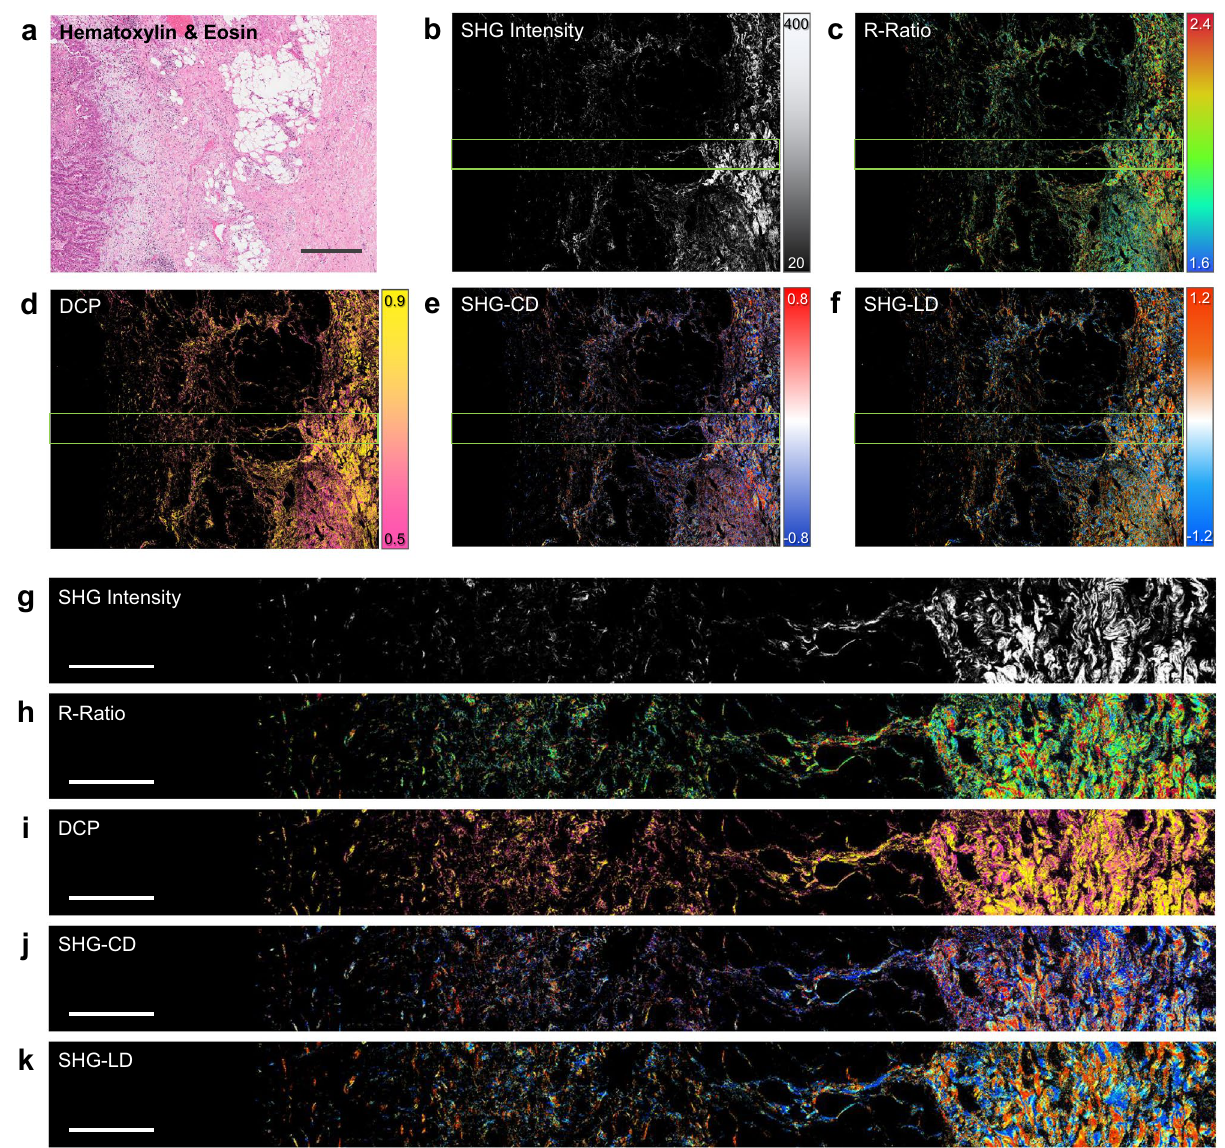
Figure 1. P-SHG microscopy of lung tissue tumor margin. A large region of human lung tissue is depicted in Hematoxilin and Eosin (H&E) stained white-field image ( a ), Second-Harmonic Generation (SHG) intensity ( b ), R-ratio ( c ), Degree of Circular Polarization ( d ), as well as, SHG circular ( e ) and linear dichroism ( f ), respectively. Scale bar 500 µ m . Close up regions of the tissue corresponding to area highlighted by green border showcase the variation of polarimetric parameters from tumor (left side) to normal-like (right side) tissue ( g – k ). Scale bar 200 µ m